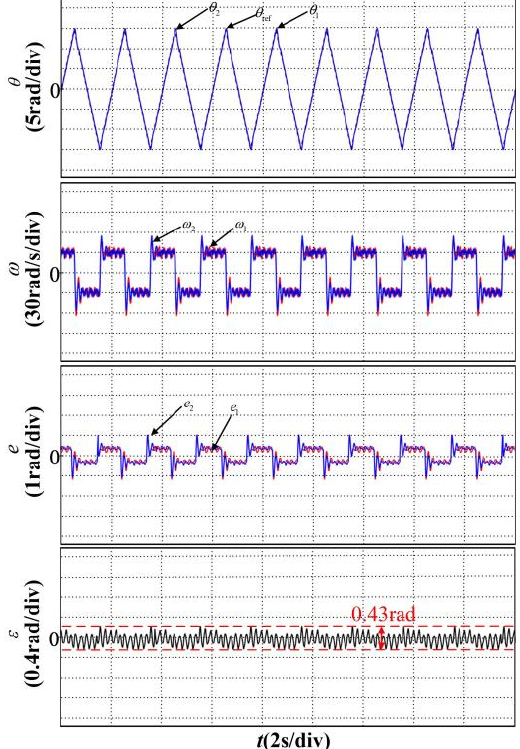
Figure 14. Motor responses when R changes.